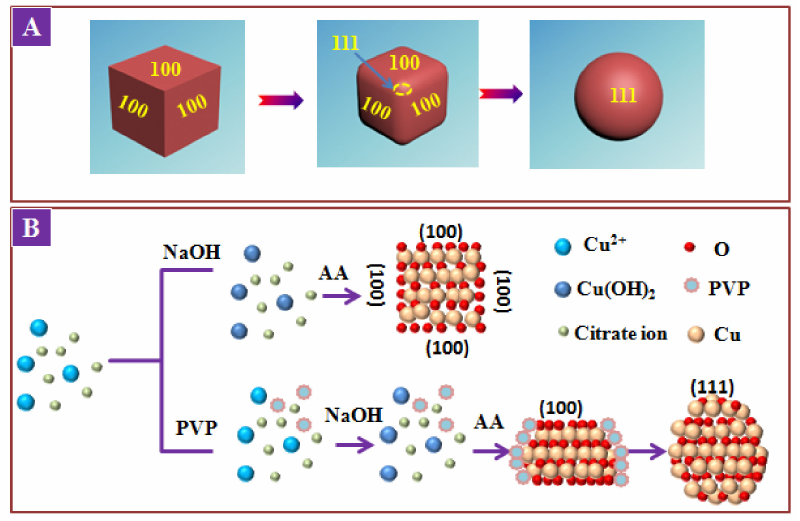
Figure 4. ( A ) the changing of exposing surface and ( B ) the role of PVP during Cu 2 O nanocrystal preparation